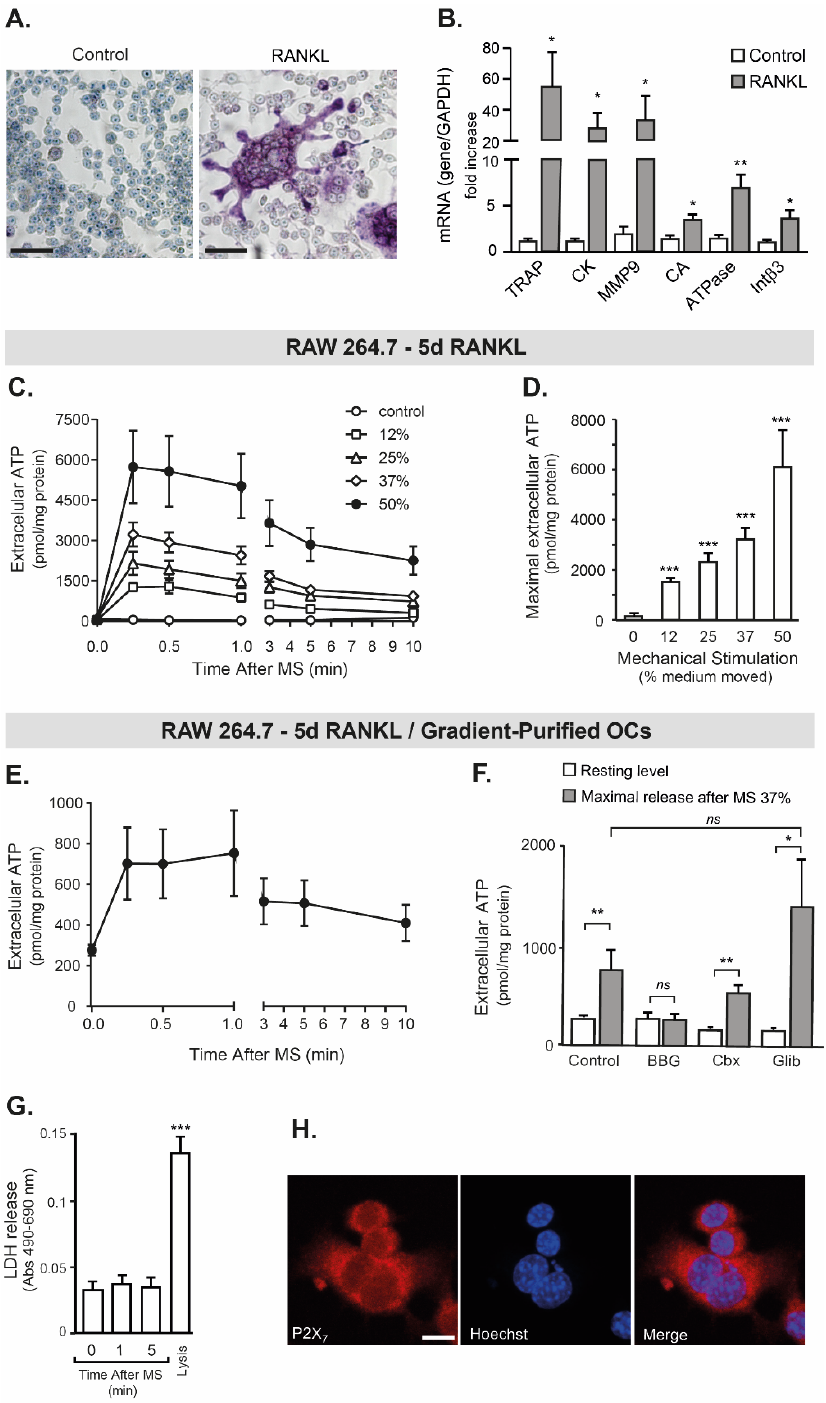
Figure 2. Mechanical stimulation induced ATP release from osteoclasts, dependent on the P2X 7 receptor. ( A ) Incubation with RANKL evoked differentiation of RAW264.7 monocytes into TRAP+ multinucleated osteoclasts. TRAP expression was assessed by cytochemistry in RAW264.7 cells either in control (left panel) or incubated for 5d with 35 ng/mL RANKL (right panel). Cells were co-stained with hematoxylin. A representative image of n = 3 is shown. Scale bar: 25 µ m. ( B ) RANKL (5d, 35 ng/mL) evoked the expression of osteoclastogenic markers in RAW264.7 cells. TRAP: Tartrate resistant acid phosphatase, CK: Cathepsin K, MMP9: Metalloprotease 9, CA: Carbonic anhydrase, ATPase: Lysosomal ATPase, Intß3: Integrin ß3. mRNA relative quantitation was performed using